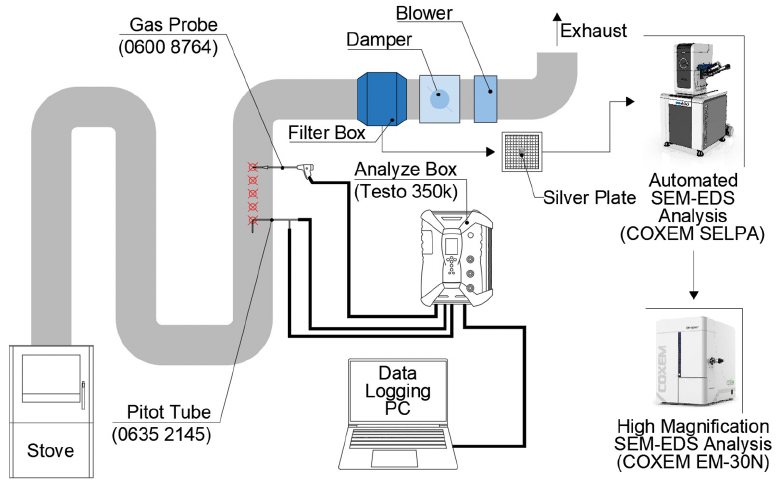
Figure 1. Diagram of test infrastructure for incineration experiment of waste mulching